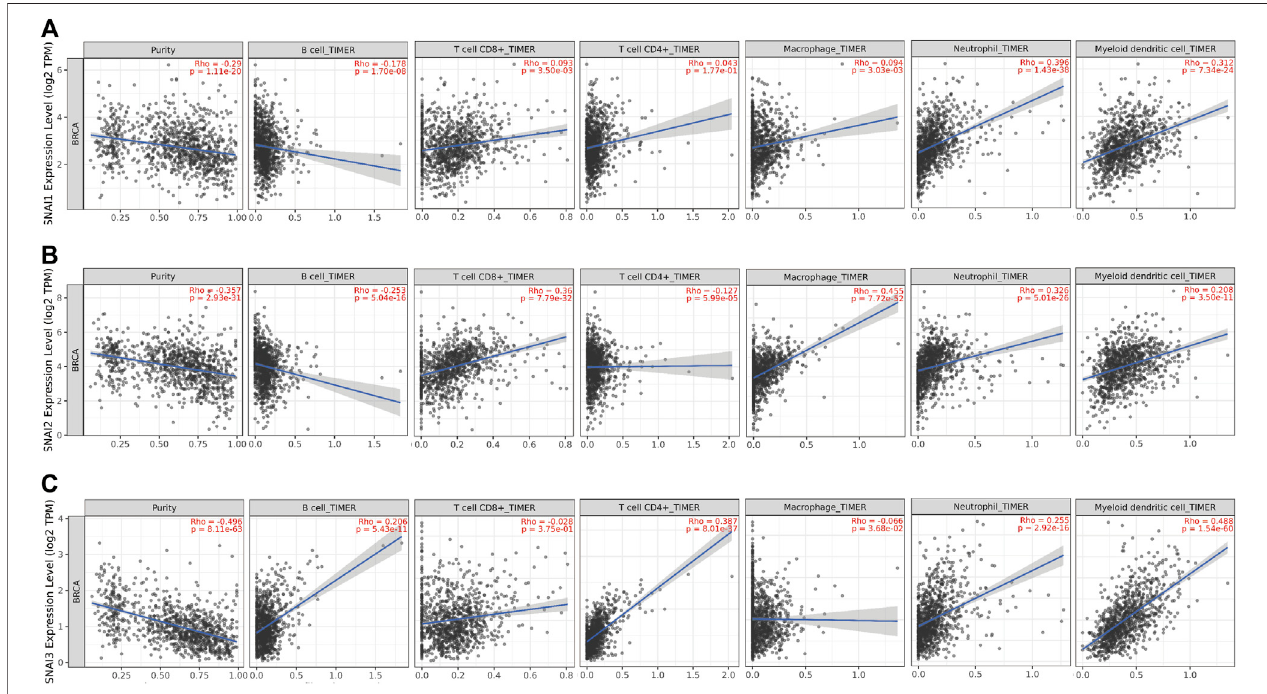
FIGURE5| CorrelationsbetweendifferentiallyexpressedSNAIsandimmunecellin fi ltrationinbreastcancer.Correlationsbetweentranscriptlevelsof (A) SNAI1 (B) SNAI2 , and (C) SNAI3 and the in fi ltration of B cells, CD8 + T cells, CD4 + T cells, macrophages, neutrophils, and dendritic cells in breast cancer are shown.